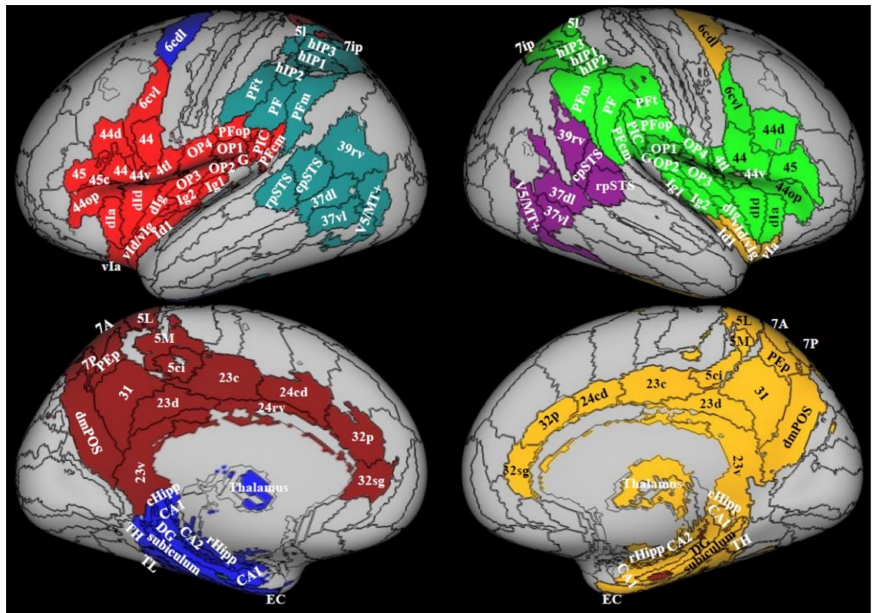
Figure 1. Multimodal vestibular cortex. Reproduced with permission from Indovina et al., 2020 [55], published by Elsevier Inc. Areas in color were selected as belonging to the multimodal vestibular cortex. Each color represents a module, that is, a cluster of areas highly connected. Data from 794 right-handed individuals. There are 4 modules on the left and 3 on the right. Regions from the Anatomy atlas [52] and Brainnetome atlas [53] are overlapped onto the Conte69 inflated brain in workbench viewer [63]. Parietal opercula 1, 2, 3, 4 (OP1, 2, 3, 4), hypergranular insula (G), superior temporal sulcus (STS), visual motion complex (V5/MT+), caudal dorsolateral area 6 (6 cdl), area 4 tongue and larynx region (4 tl), granular insula 2 (Ig2), granular insular 1 (Ig1), Area supramarginalis opercularis (PFop), rostroventral area 40 (PIC), area supramarginalis columnata magnocellularis (posterior) (PFcm), area supramarginalis tenuicorticalis (PFt), area supramarginalis (PF), area supramarginalis magnocellularis (PFm), right posterior superior temporal sulcus (rpSTS), caudal posterior superior temporal sulcus (cpSTS), dorsolateral area 37 (37dl), ventrolateral area 37 (37vl), rostroventral area 39 (39 rv), human intraparietal 1, 2, 3 (hIP1, 2, 3), lateral area 5 (5I), intraparietal area 7 (7ip), superial parietal lobe: 7A, 5L, 7O. Parvicellular superior parietal area (PEp), precuneus (5M), superior parietal lobe (5ci), area 31 (31), dorsomedial parietooccipital sulcus (dmPOS), dorsal area 23 (23d), caudal area 23 (23c), ventral area 23 (23rv), caudodorsal 24 (24cd), pregenual area 32 (32p), subgenual area 32 (32sg), caudal hippocampus (cHipp), cornu ammonis 1 (CA1), hippocampotemporalis (TH), subiculum, latero posterior parahippocampal gyrus (TL), Cornu Ammonis 2 (CA2), dental gyrus (DG), rostal hippocampus (rHipp), cornu ammonis 1 (CA1), entorhinal cortex (EC), caudal ventrolateral area 6 (6cvl), dorsal area 44 (44d), rostral area 45 (45), caudal area 45 (45c), opercular area (44op), dorsal agranular insular (dIa), ventral agranular insula (vIa), ventral dysgranular and granular insula (VId/dIg), dysgranular insula (Id1), dorsal granular insula (dIg), dorsal dysgranular insula (dId), granular insula 2 (Ig2), ventral area 44